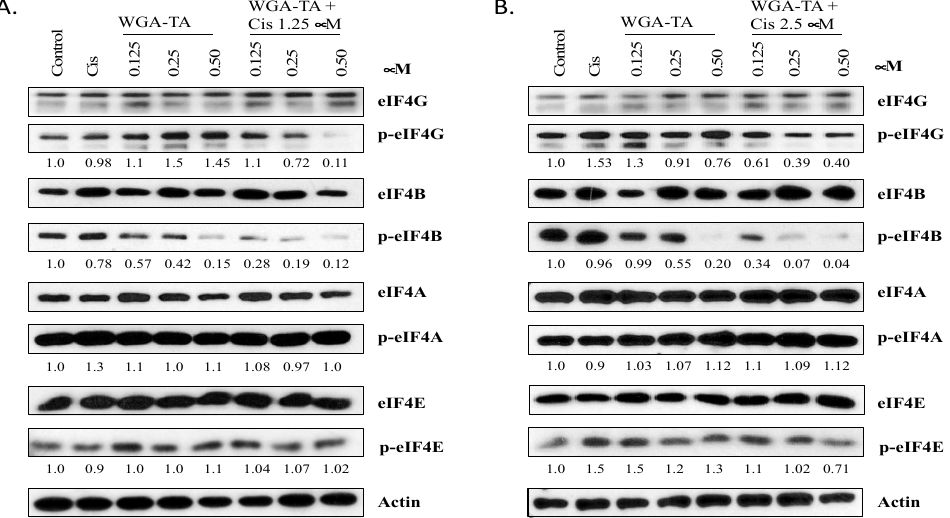
Figure 3. ( A , B ). Western blot showing the treatment effect on translation initiation. MDA-1986 cells were treated with either 1.25 ( A ) or 2.5 ( B ) μ M cisplatin either alone or in combination with either 0.125 or 0.25 or 0.50 μ M TA-WGA for 24 h. Solvent treated samples served as control. Post-treatment cells were collected, and equal amounts of proteins (20 μ g) were loaded on SDS-PAGE gel and transferred onto a nitro cellulose membrane. The membranes were incubated with primary antibodies of translation complex proteins. The membranes were then treated with appropriate secondary antibodies and the blots were then developed using ECL.